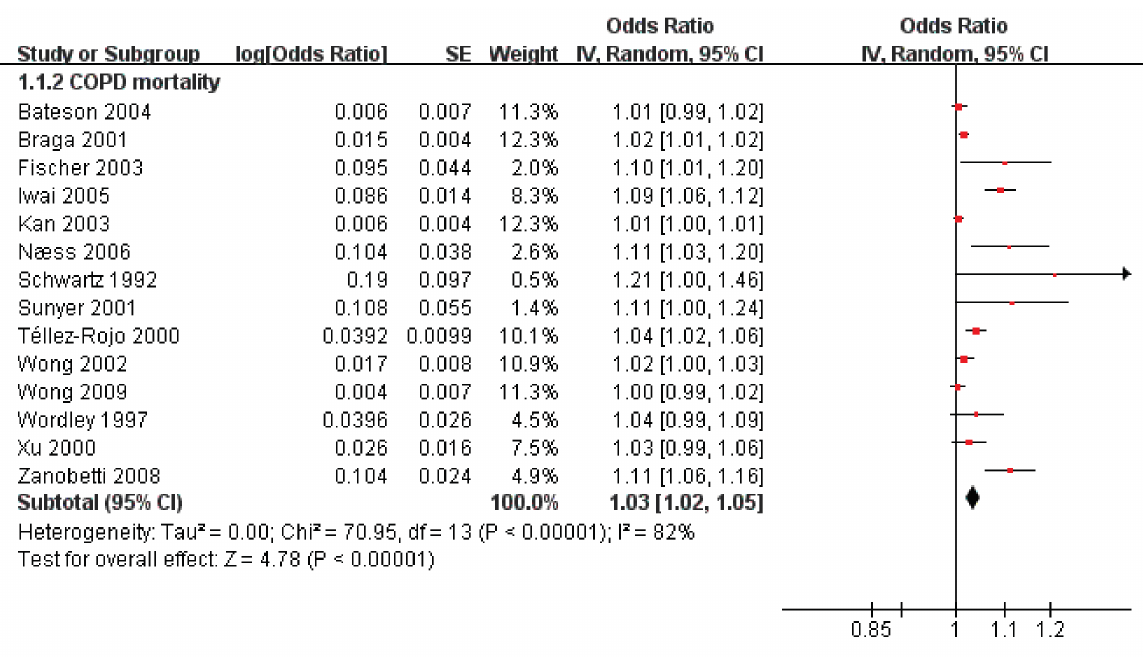
Figure 2. The effect of outdoor air pollution on COPD mortality.